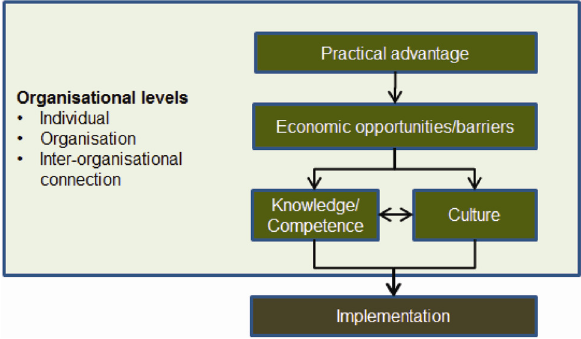
Fig. 4. Approach to factors affecting IT adoption and their rela- tions (from the first case study)